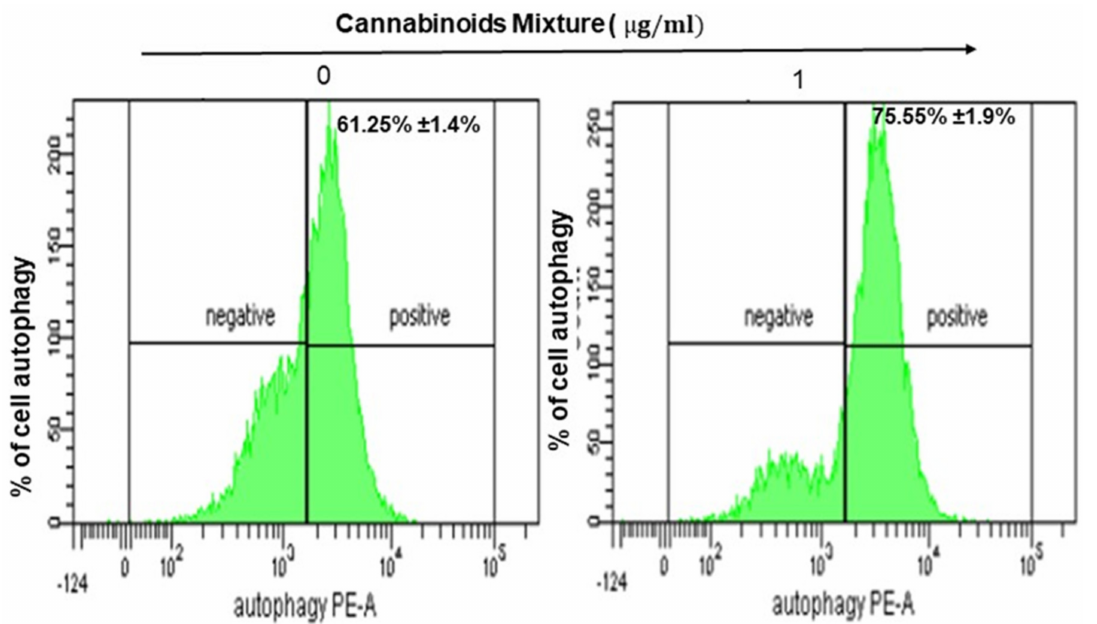
Figure 3. CM induces autophagy: Representative flow cytometry histogram of Ca9-22 cells stained with the autophagy probe. Results are expressed as mean ± SEM ( n =